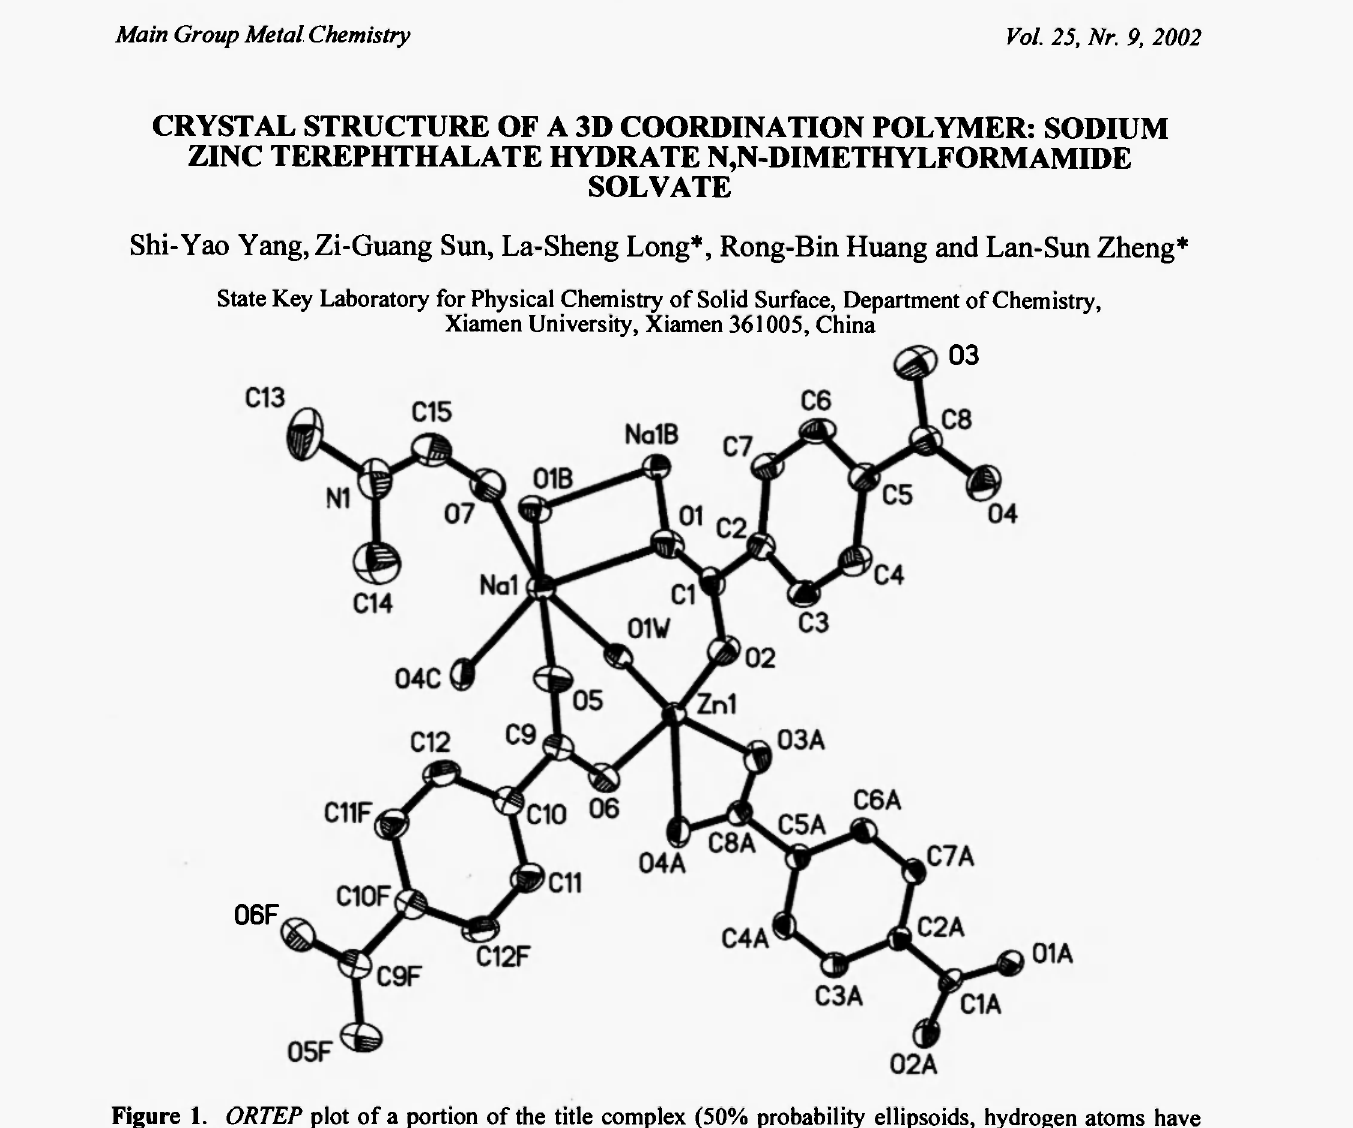
Figure 1. ORTEP plot of a portion of the title complex (50% probability ellipsoids, hydrogen atoms have been omitted for clarity). Selected bond distances and angles: Znl-02 1.932(2), Znl-03a 1.953(3), Znl-06 1.955(2), Znl-Olw 1.991(3), Znl-04a 2.756(3), Nal-05 2.310(3), Nal-Olb 2.371(3), Nal-04c 2.373(3), Nal-07 2.427(3), Nal-Ol 2.472(3), Nal-Olw 2.505(3), Ol-Nalb 2.371(3) A, 02-Znl-03a 99.09(11), 02- Znl-06 109.48(12), 03a-Znl-06 119.09(12), 02-Znl-01w 108.89(11), O3a-Znl-Olw 113.09(12), 06- Znl-Olw 106.70(11), 05-Nal-07 100.24(11), 05-Nal-01 89.01(10), 07-Nal-0 1 89.80(10), 05-Nal- Olw 90.60(10), 07-Nal-01 w 162.57(11), Ol-Nal-Olw 76.68(10)°, Symmetry operations: a = l+x, M2-y, 1 /2+z, b = -x,\ -y, 1 -z,c = -χ, 1 /2+y, 1